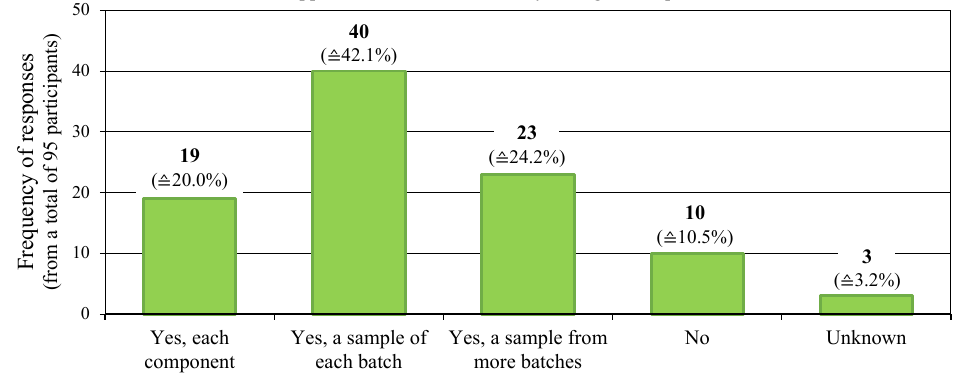
Figure 4. Response of 95 participants to the (single-choice) question: “Do you inspect incoming components from external suppliers to evaluate conformity with given requirements?”.